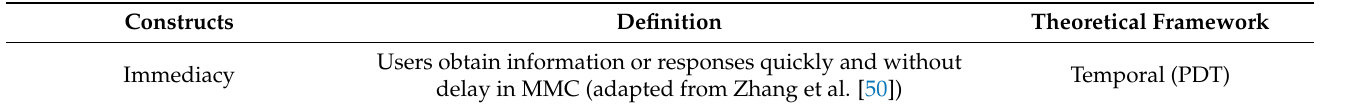
Table 1. Construct